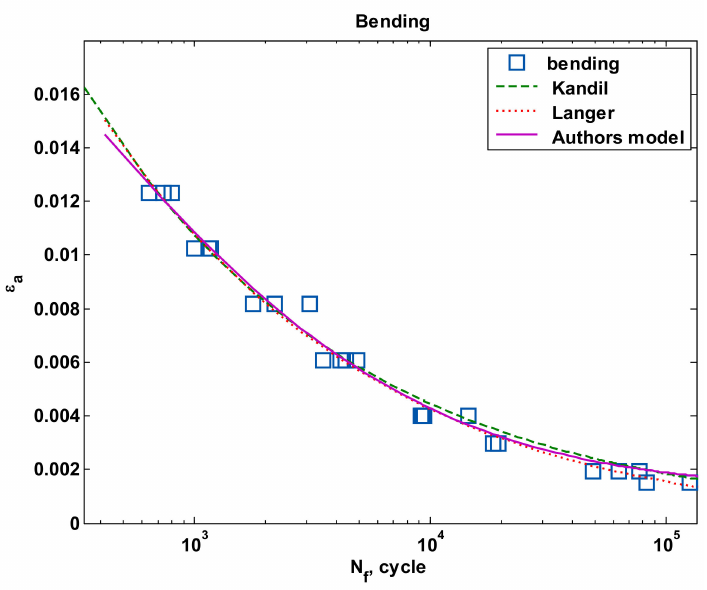
Figure 13. The strain amplitude for individual models under